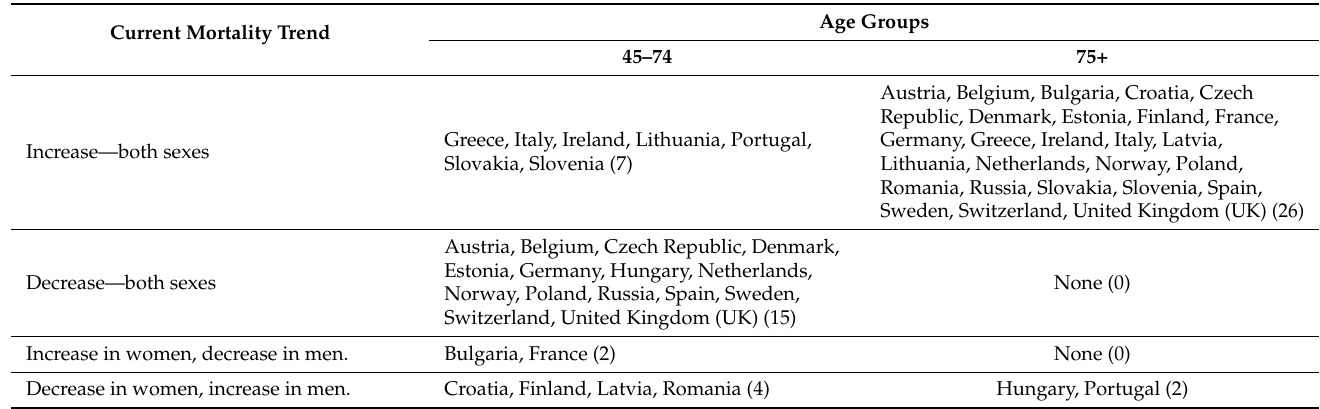
Table 1. Melanoma-mortality-trends matrix for European countries by age group, sex, and